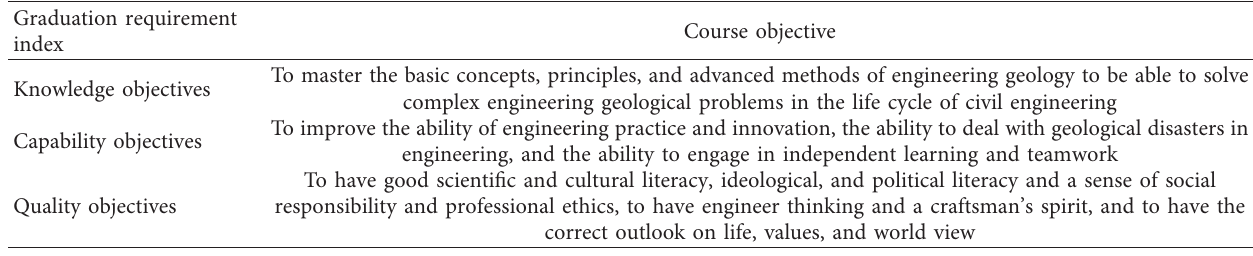
Figure 1: Course goal achievement evaluation Table 1: Correspondence between the course objectives and graduation requirements.